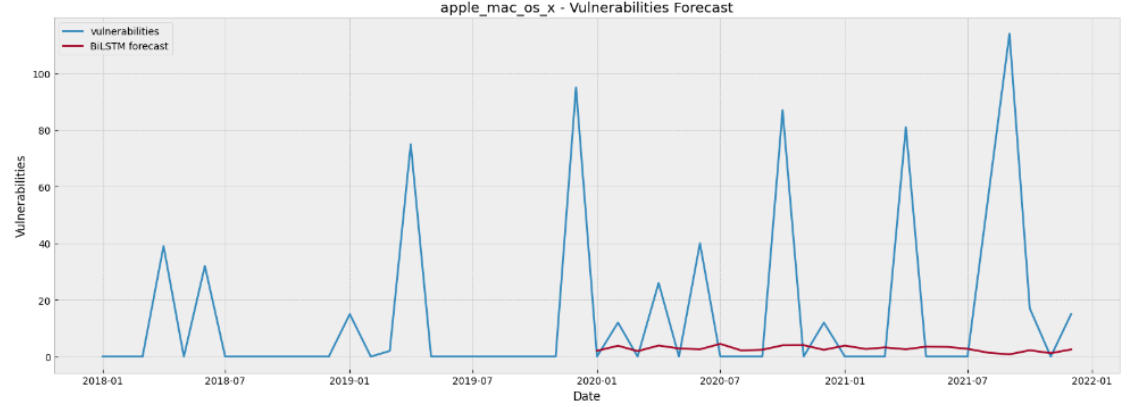
Figure 6. Apple macOS X vulnerability forecasting for 24 steps ahead using